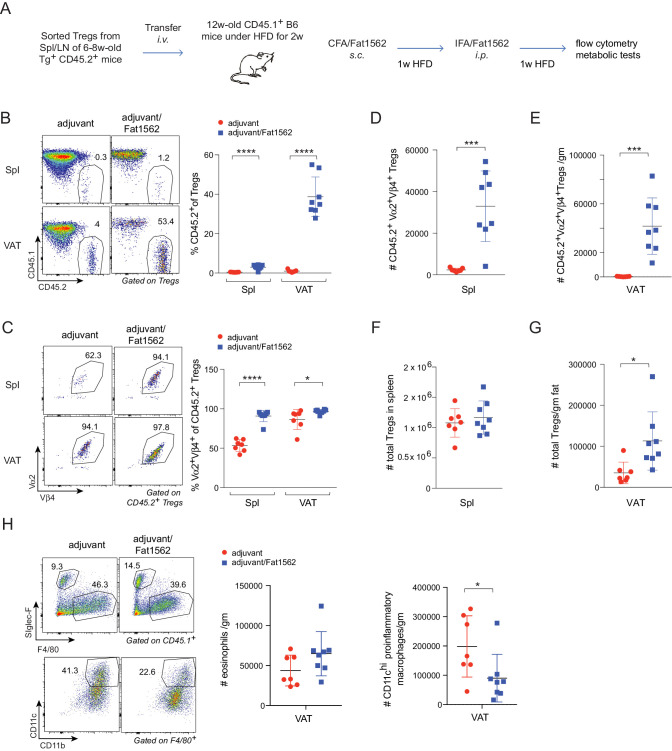
Immunization with Fat1562 expands transferred vTreg53 Treg cells and suppresses HFD-induced VAT inflammation.(A) Scheme of the transfer and immunization protocol. (B) Frequencies of CD45.2+ cells in Treg cells (n ≥ 7). (C) Frequencies of clonotype+ cells in transferred CD45.2+ Treg cells (n ≥ 7). (D) Number of clonotype+ CD45.2+ Treg cells in the spleen (n ≥ 7). (E) Number of clonotype+ CD45.2+ Treg cells in the VAT (n ≥ 7). (F) Number of total Treg cells in the spleen (n ≥ 7). (G) Number of total Treg cells in VAT (n ≥ 7). (H) Numbers of eosinophils and CD11chi inflammatory macrophages in VAT (n ≥ 7). Data are mean ± SD. Data shown are representative of at least two independent experiments.